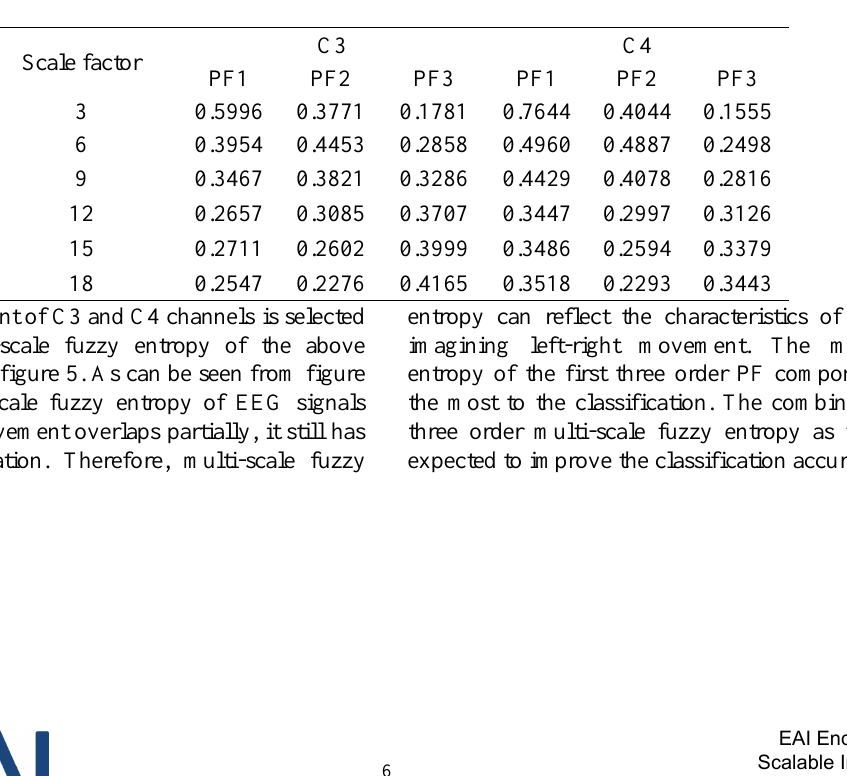
Table 1. The mean multiscale fuzzy entropy of Imagine right hand